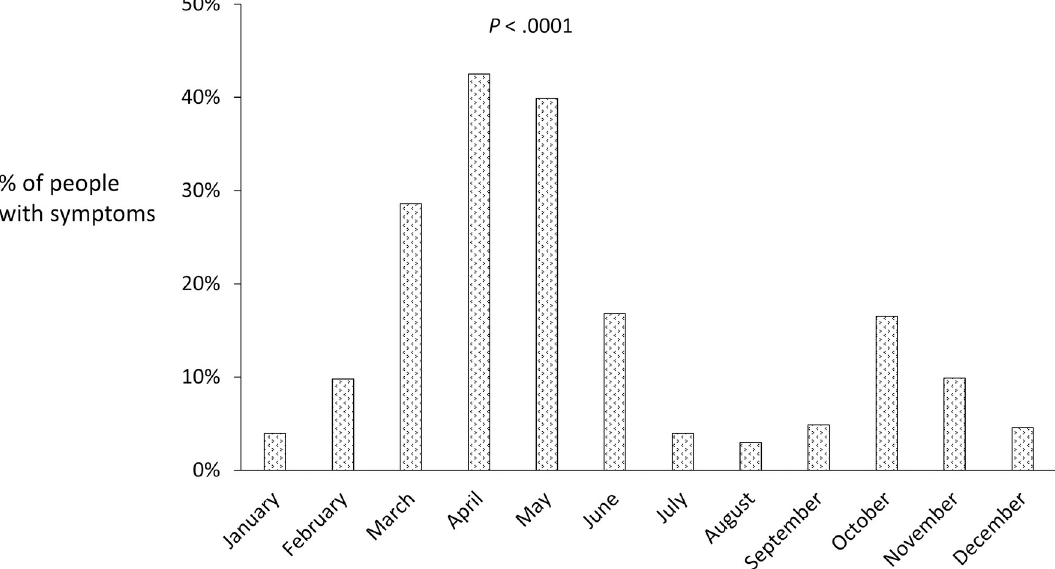
Fig 4. Percentage of participants presenting symptoms of respiratory allergy, by months of the year.